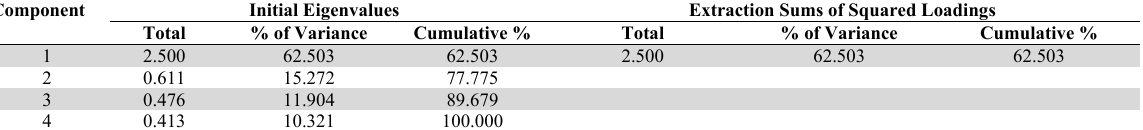
Total Variance Explained